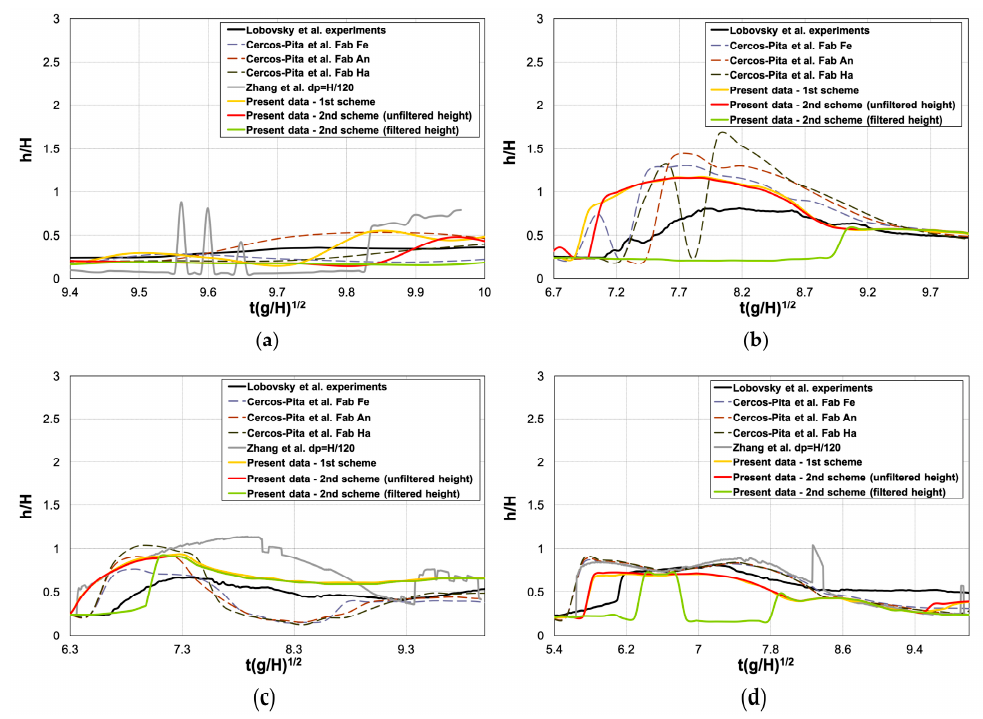
Figure 5. Water surface elevation comparison between the numerical results and the experimental data from the secondary wave arrival: ( a ) H 1 ; ( b ) H 2 ; ( c ) H 3 ; and ( d ) H 4